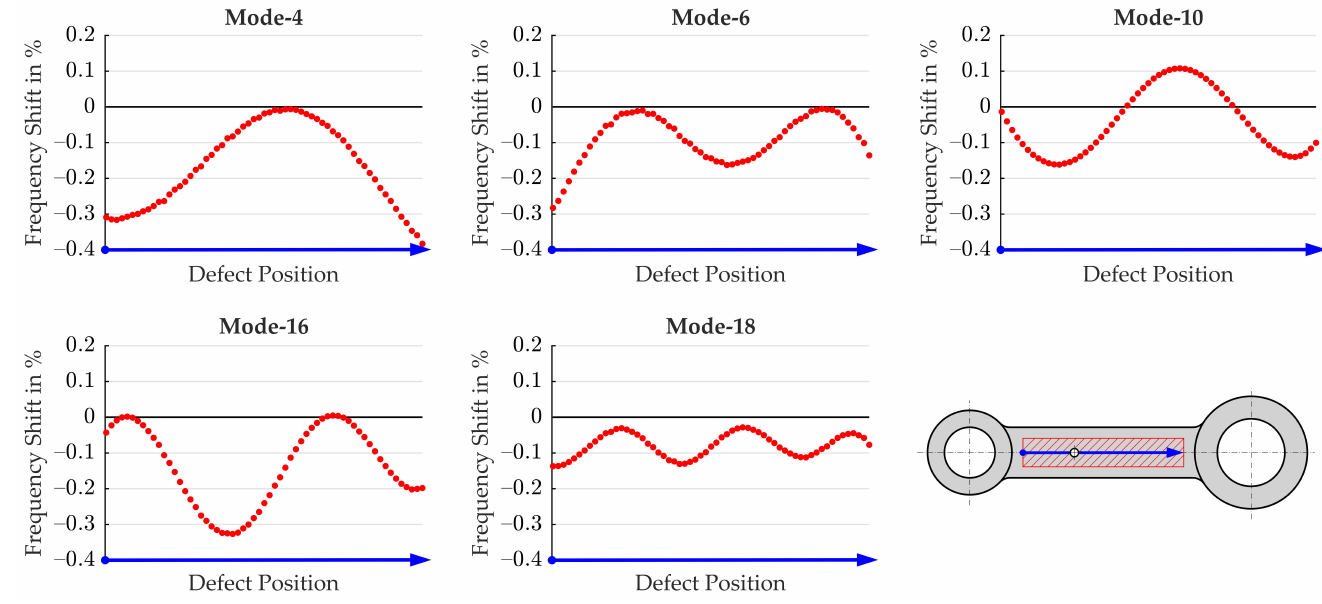
Figure 5. Relative defect impact on the eigenfrequencies of a connecting rod depending on the position of a 2 mm through-hole defect in the bar, taking the example of the geometrically mean